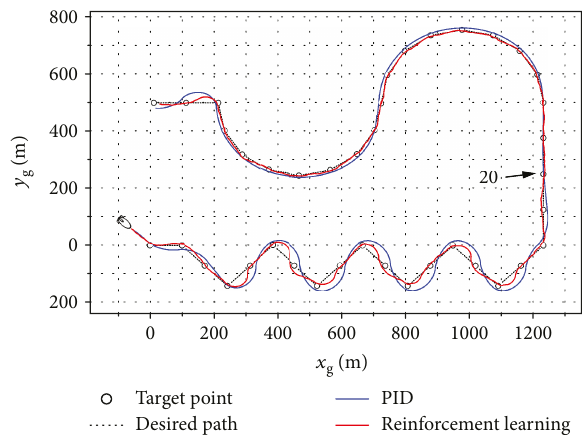
Figure 8: The airship planar path-following control.